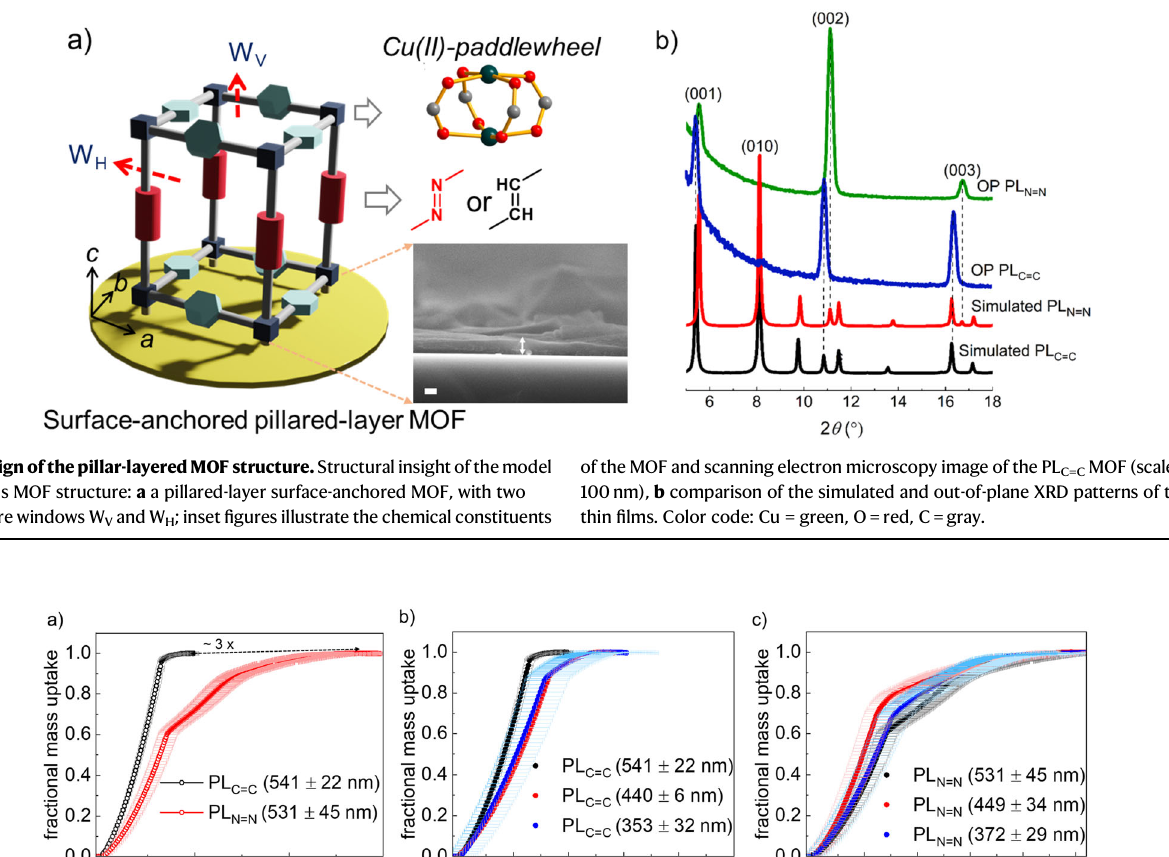
Fig. 3 | Methanol vapor uptake rates. Mass uptake rate studies: a fractional methanol vapor mass uptake rate pro fi les at 298K for PL C=C and PL N=N ,